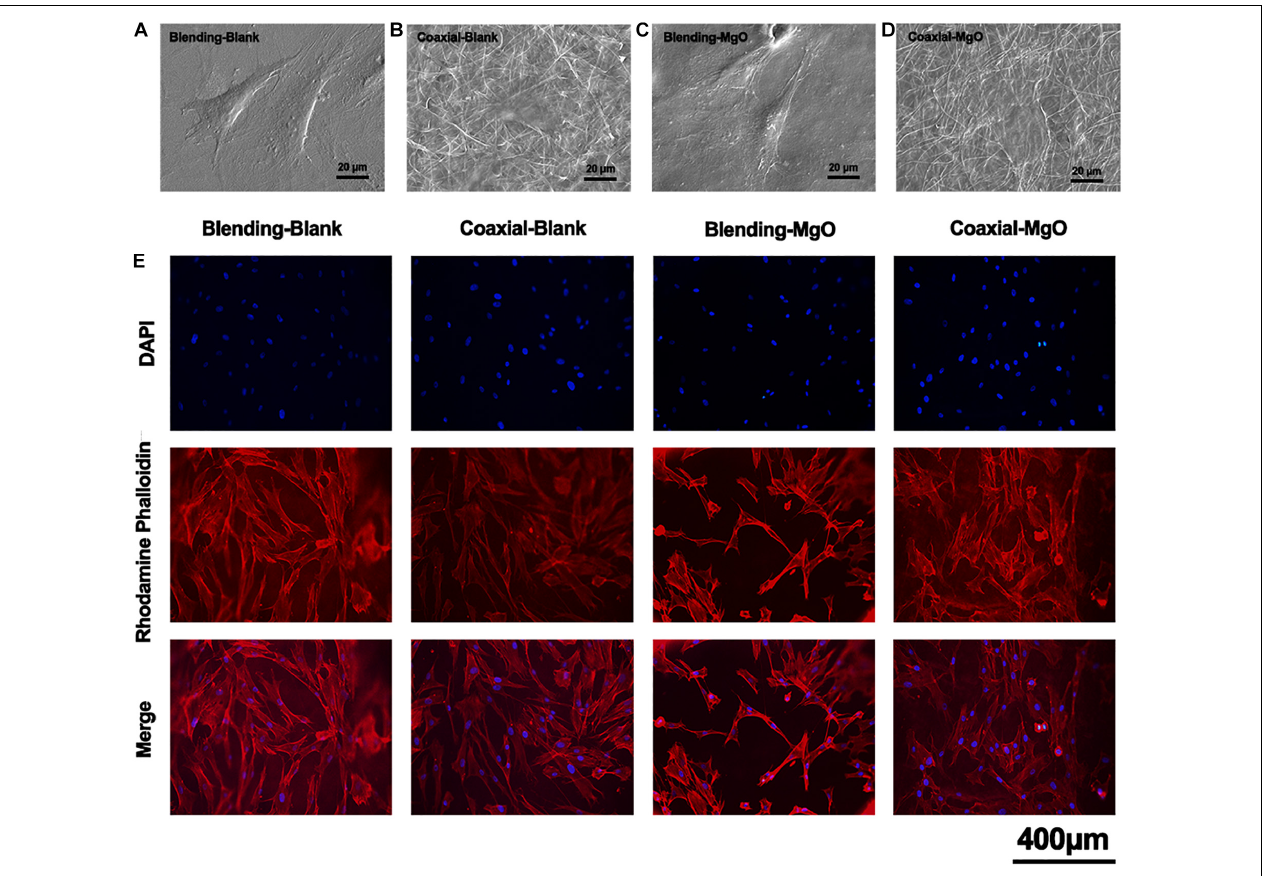
FIGURE 4 | Cell morphology and attachment on the electrospun membranes. SEM micrographs of hPDLSCs cultured on (A) Blending-Blank, (B) Coaxial-Blank, (C) Blending-MgO, and (D) Coaxial-MgO for 24 h. (E) Fluorescent staining of hPDLSCs cultured on electrospun membranes for 24 h. Red, cytoskeleton stained by rhodamine phalloidin; Blue, nuclei stained by